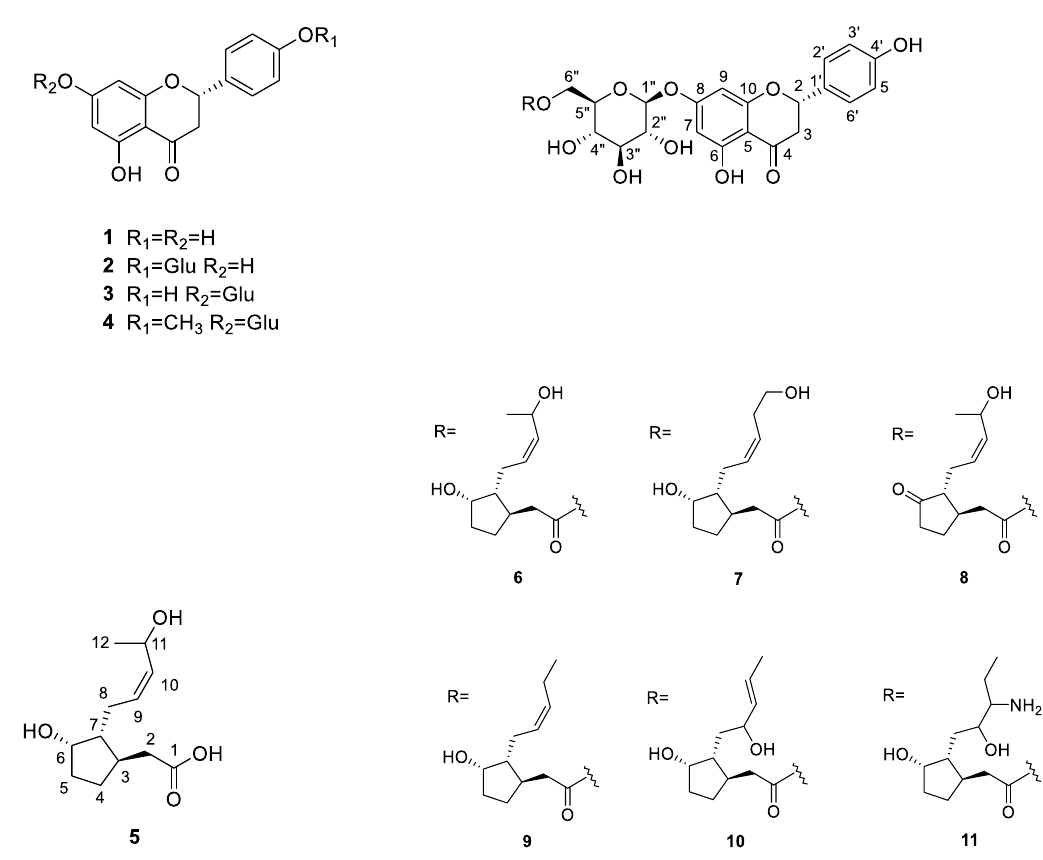
Figure 1. Chemical structures of compounds from MJ-treated wild ginseng adventitious root